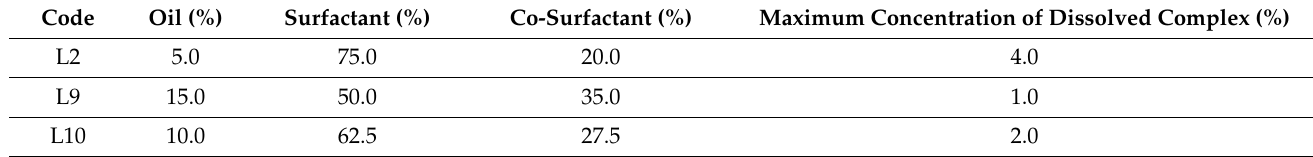
Table 8. The maximum payload of the LYS:SDS complex in liquid SEDDS.